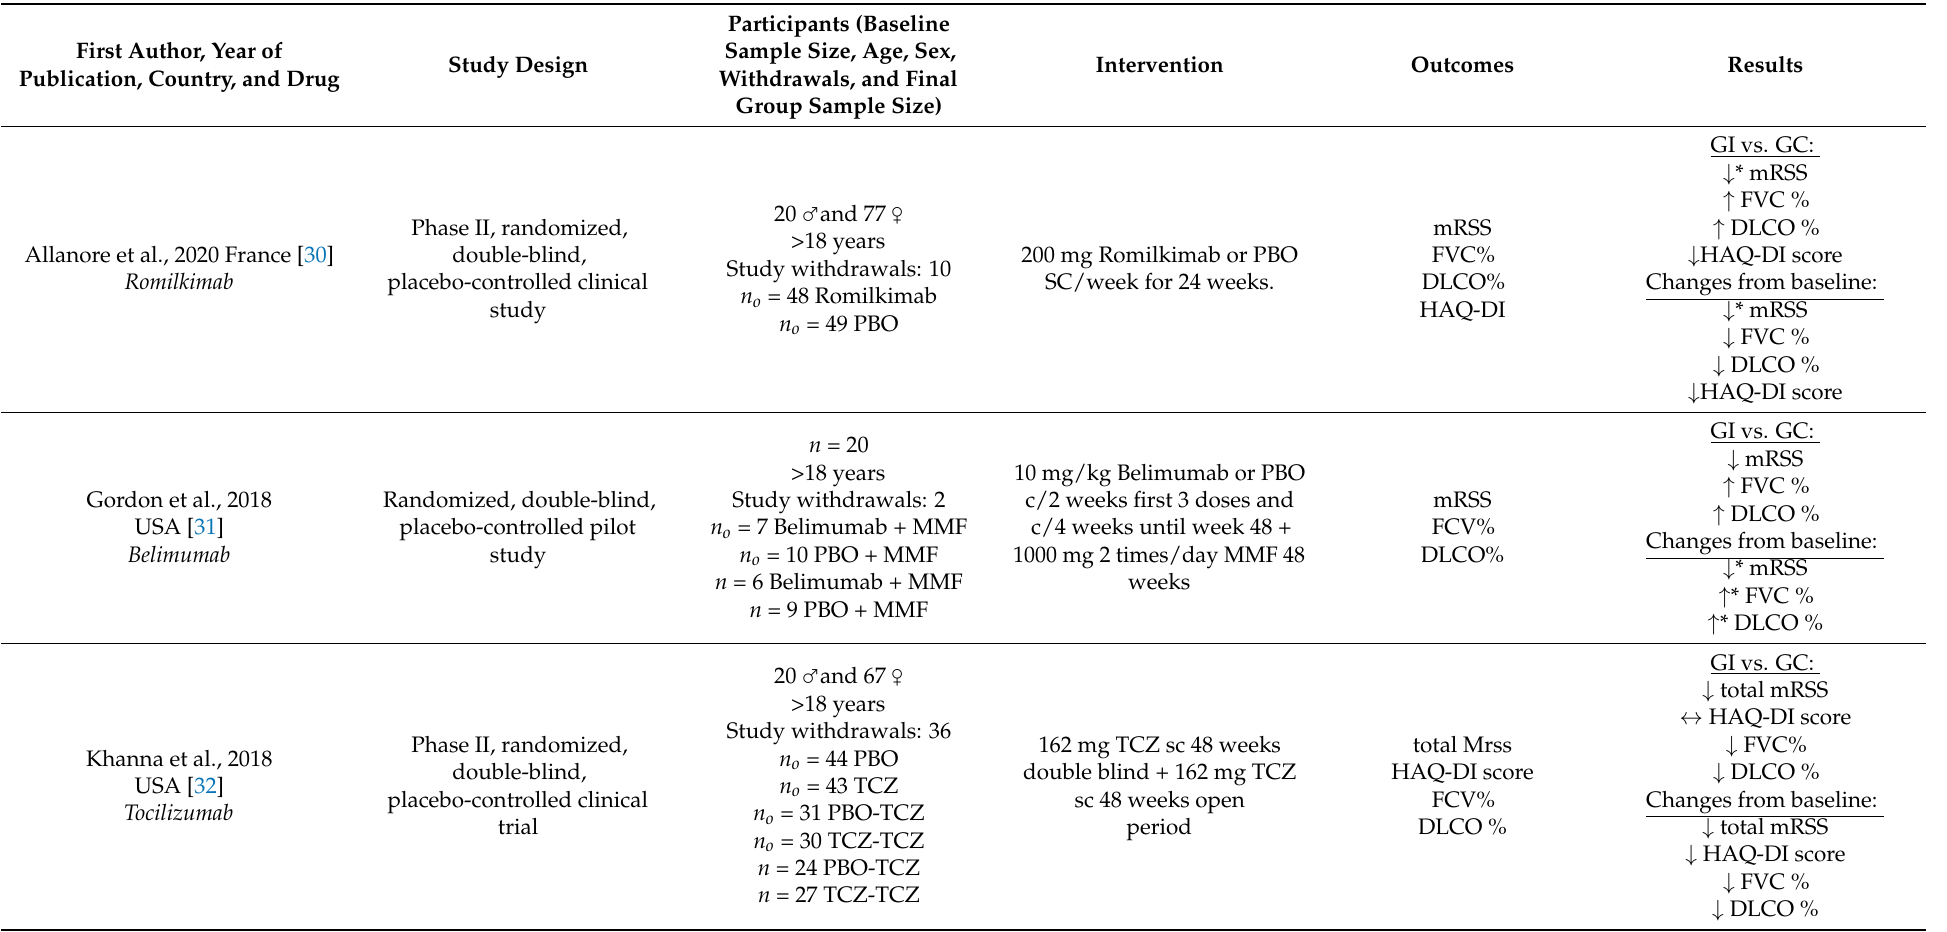
Table 5. Studies included in the systematic review of the effect of biological drugs on health biomarkers in patients afflicted by diffuse cutaneous systemic